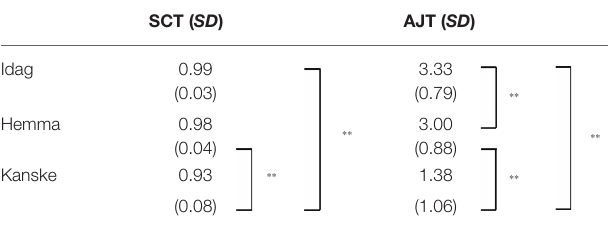
TABLE 4 | Scores on sentence completions and accuracy